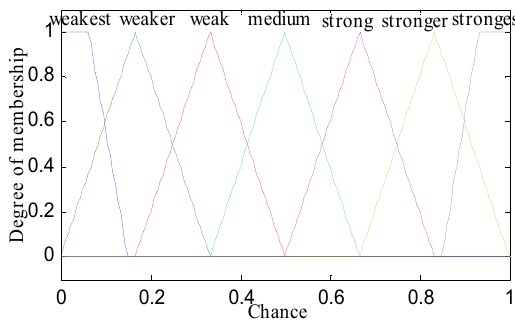
Figure 3. Membership function of ND (node density).